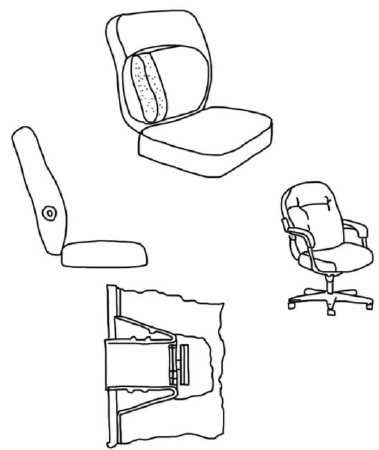
Figure 31. US Patent 5,660,438 Seat cushion [20].